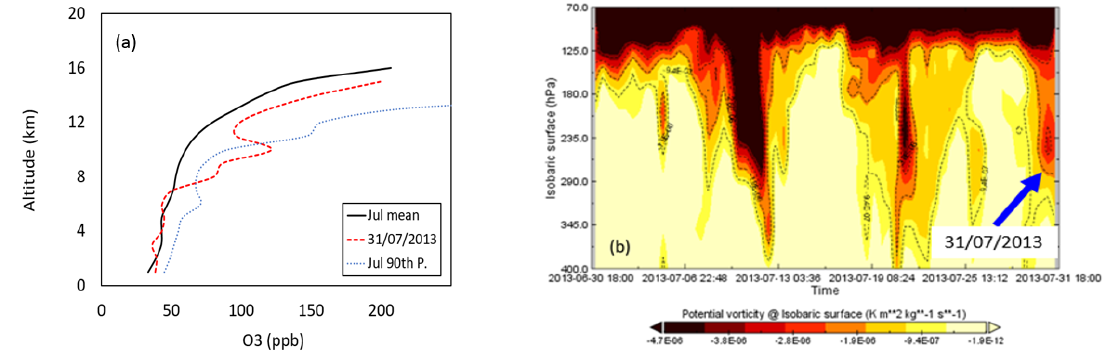
Figure 8. ( a ) Ozone troposphere profile over Irene on 31 July 2013. ( b ) Potential vorticity at Isobaric surface over Irene on July 2004 (from MERRA-2). Solid line in Figure 8a indicates monthly O 3 average composite, broken line indicates O 3 event and dotted line indicate 90th percentile composite. Colours in Figure 8b indicates the level of potential vorticity, black indicates high potential vorticity of more than 3 Km − 2 kg − 1 s − 1 while yellow indicates potential vorticity of less than 2 Km − 2 kg − 1 s − 1 . Blue arrow in Figure 8b indicates the event that is associated with O 3 profile in Figure 8a.